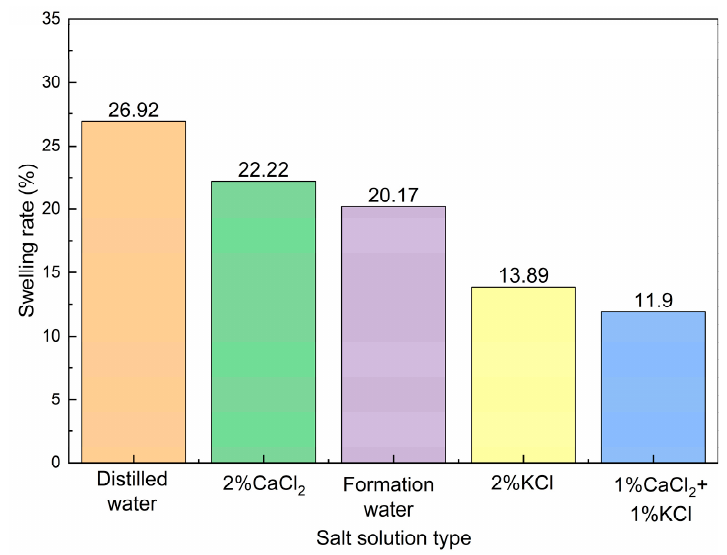
Figure 6. Swelling rate of artificial clay samples with different salt solutions (2#a).